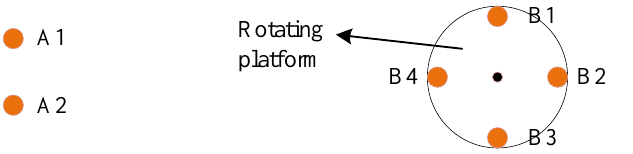
Figure 2. Installation diagram of antennae and rotating platform (A means static antennae, B means dynamic antennae).